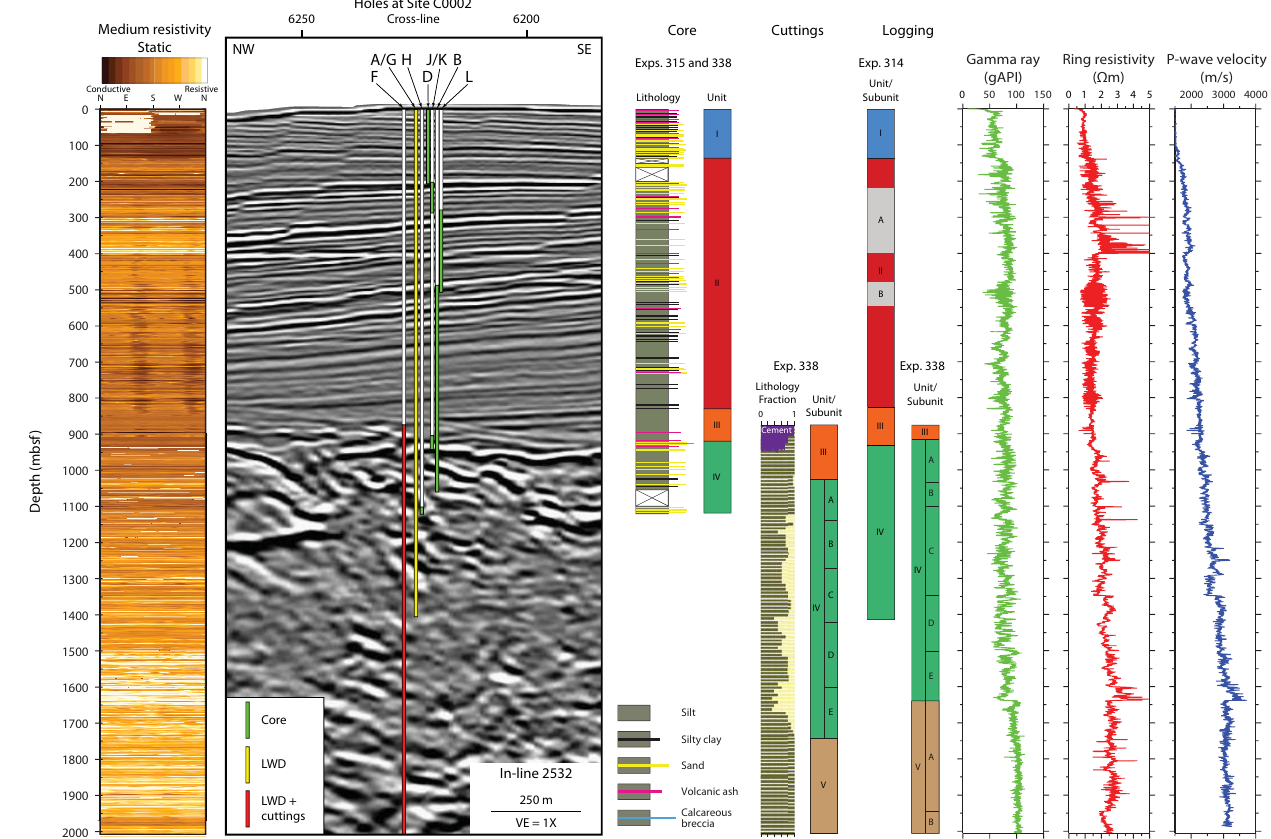
Figure 6. Cuttings-core-log-seismic integration at Site C0002: composite medium button static resistivity, In-line 2532 seismic data (Kumano 3-D PSDM volume; Moore et al., 2009), composite core lithology and units, cuttings lithology and units, logging units from holes C0002A and C0002F, and composite logging-while-drilling (LWD) data. In logging unit panel (Exp. 314), gray interval A indicates possible gas- hydrate zone, and interval B indicates possible area with small amounts of free gas (after Expedition 314 Scientists, 2009).